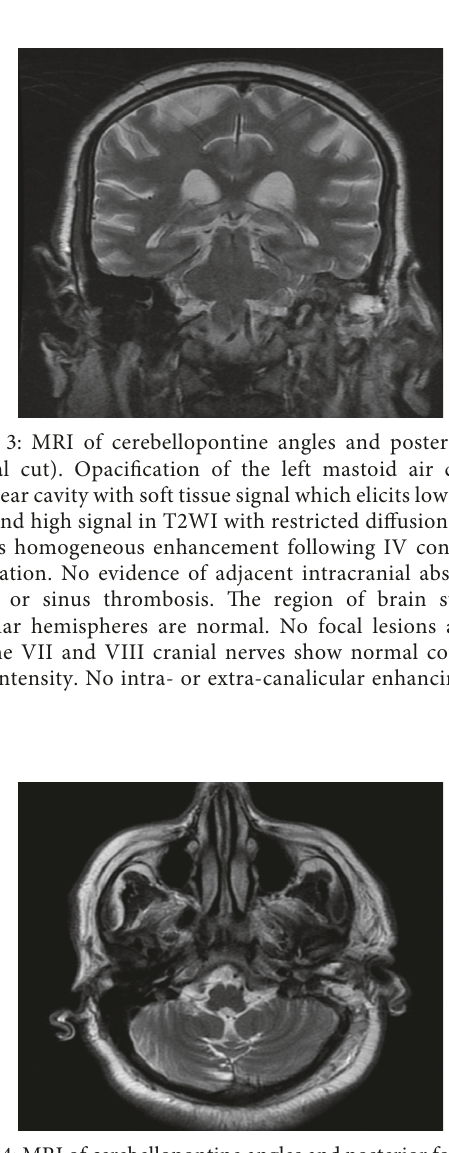
neuron facial palsy.